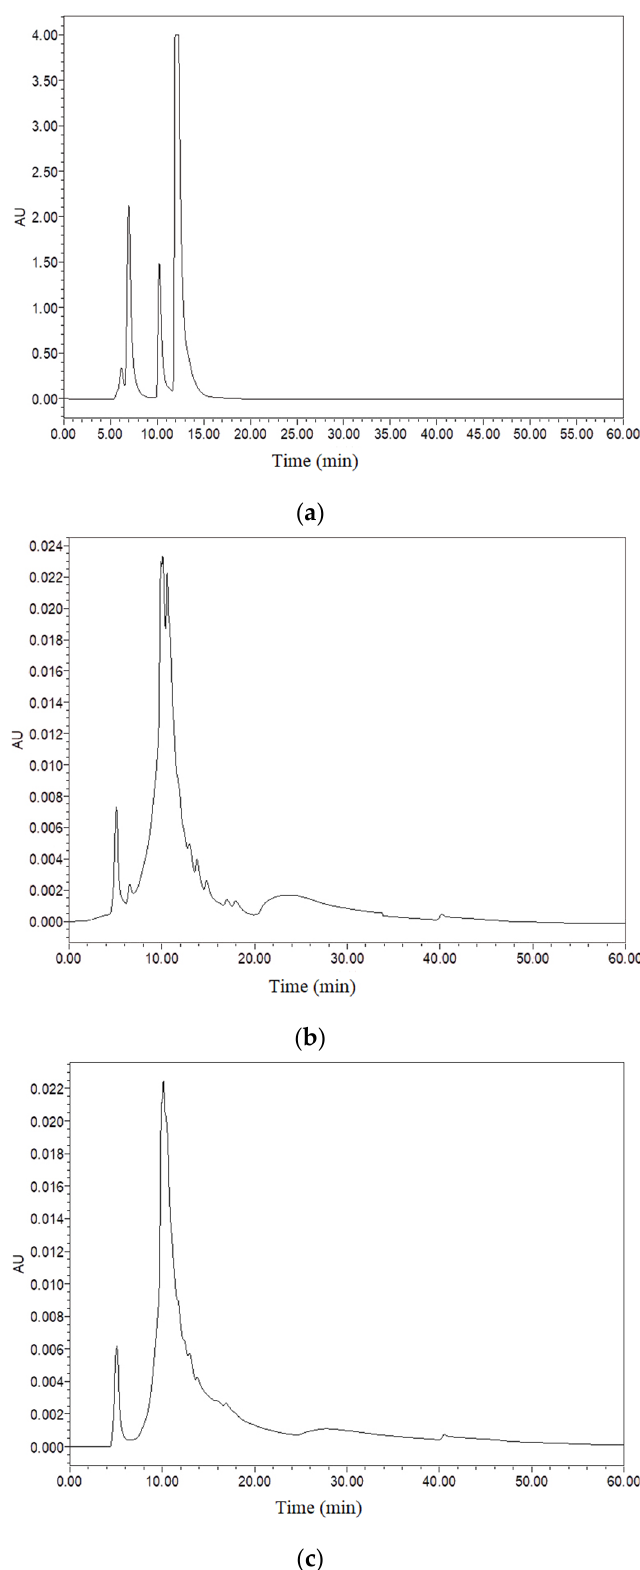
Figure 1. UF and LCF polypeptide molecular weight analysis using high − performance liquid chromatography (HPLC): ( a ) combined standards of bovine serum albumin, vitamin B12, and oxidized glutathione underwent HPLC analysis; ( b ) HPLC analysis of UF; ( c ) HPLC analysis of LCF. UF: unfermentation; LCF: single microbial fermentation with L. curvatus.